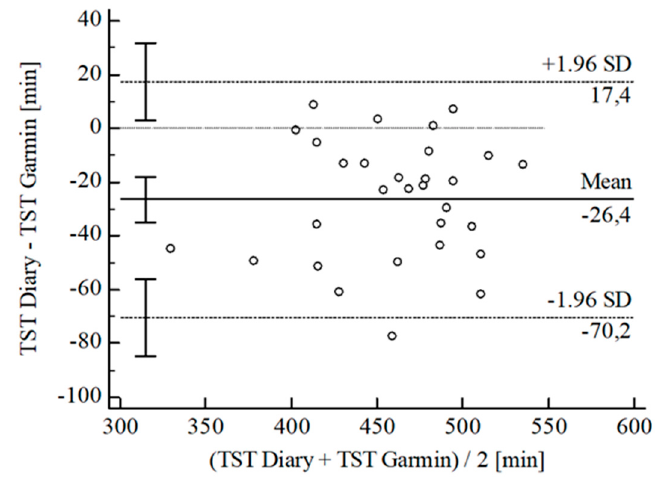
Figure 7. Bland-Altman Plot for TST Garmin ® vs. diary.